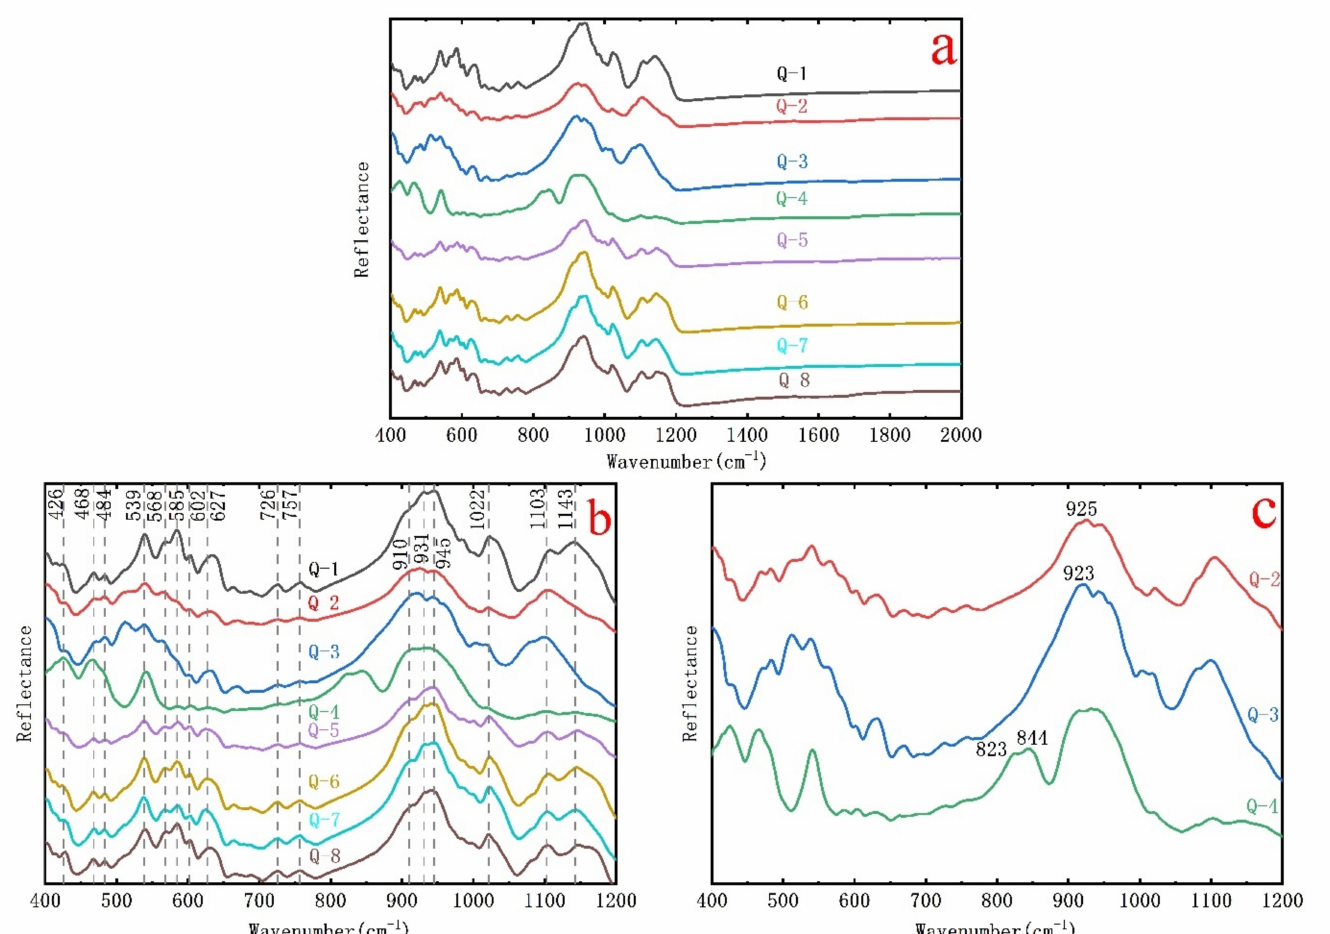
Figure 5. FTIR spectra of the samples. ( a ) FTIR spectra for all samples for the 400–2000 cm − 1 frequency range; ( b ) FTIR spectra for all samples for the 400–1200 cm − 1 frequency range; ( c ) FTIR spectra for the green samples for the 400–1200 cm − 1 frequency